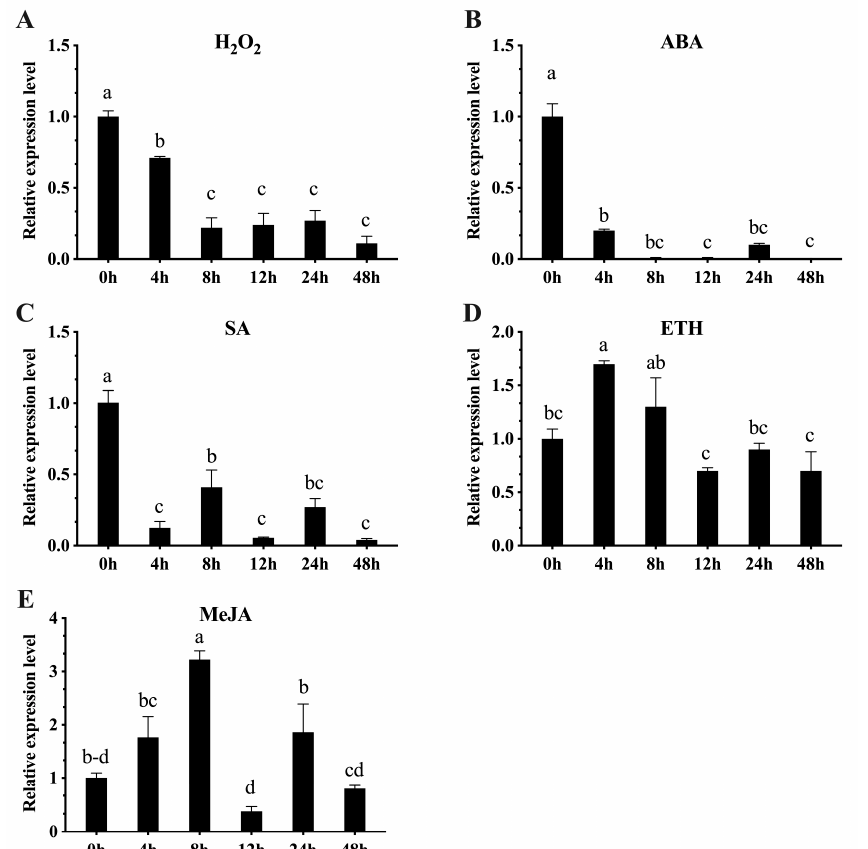
Figure 5. Quantitative real-time PCR analysis of CaBPM4 gene after signaling molecule treatments in the leaves of pepper plant. ( A ) Hydrogen peroxide (H 2 O 2 ) treatment; ( B ) abscisic acid (ABA) treatment; ( C ) salicylic acid (SA) treatment; ( D ) ethephon (ETH) treatment; ( E ) methyl jasmonate (MeJA) treatment. Relative expression levels of the CaBPM4 at different time point were determined in comparison with that in the control plants at the corresponding same time point. Results are presented as mean means ± SD of three independent biological replicates. Small letters (a–d) represent significant differences ( p < 0.05).